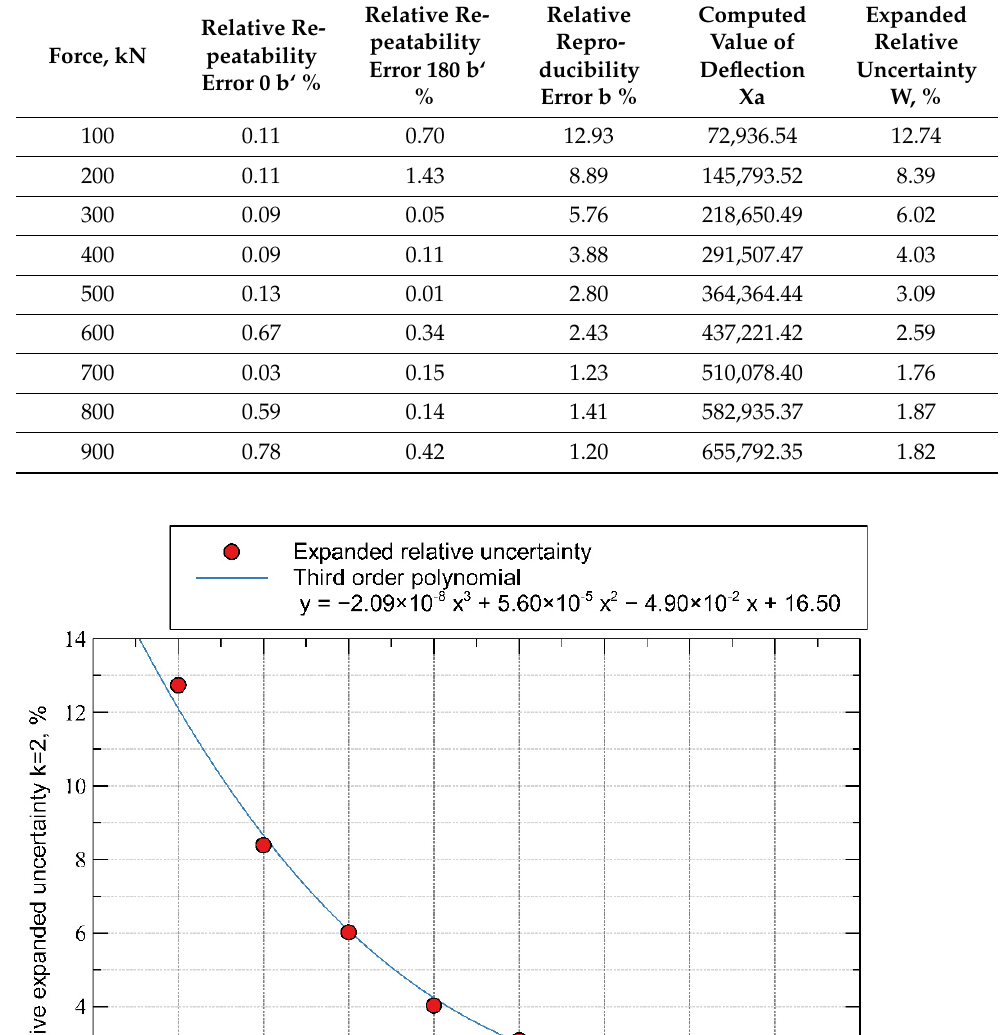
Table 3. Error and uncertainty determination results.